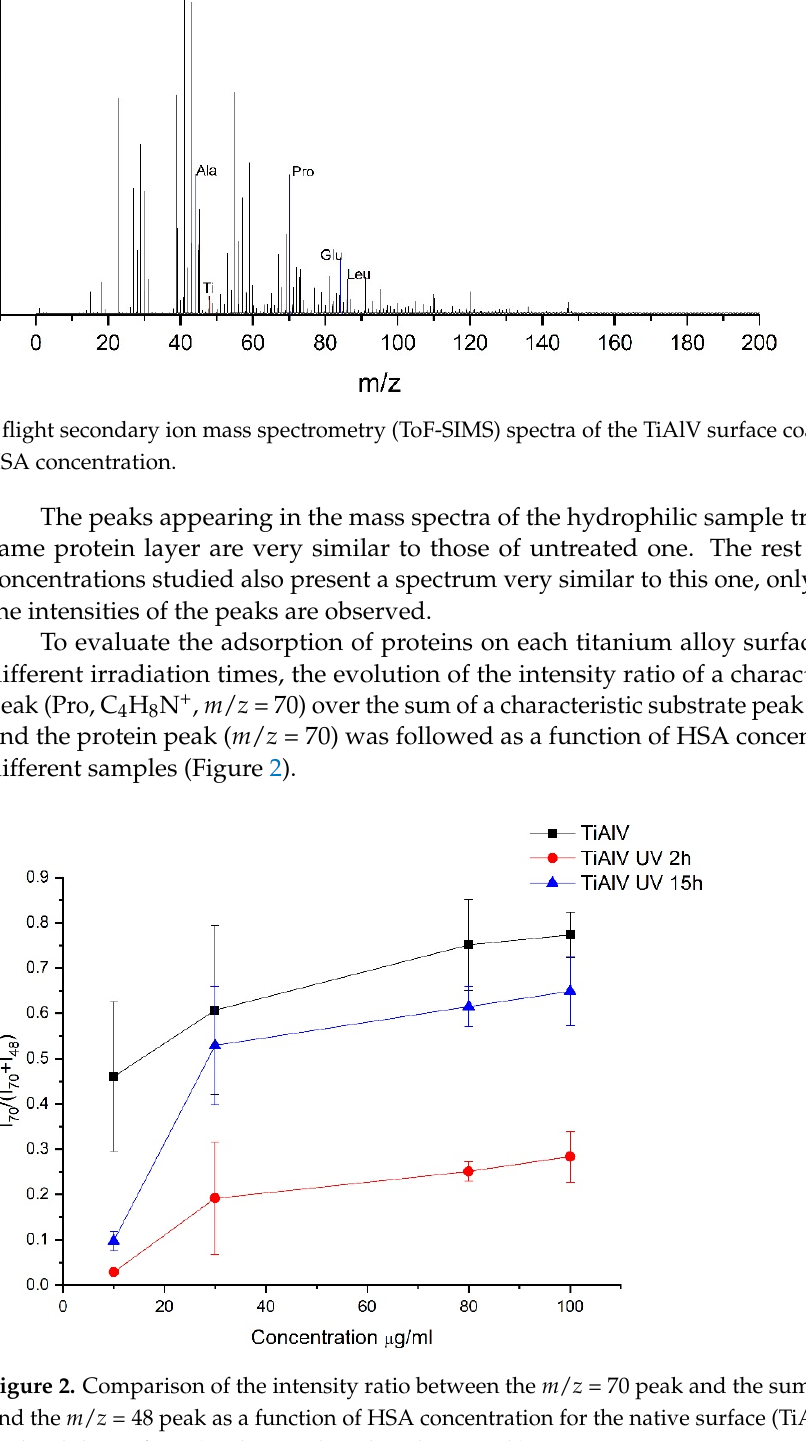
Figure 2. Comparison of the intensity ratio between the m / z = 70 peak and the sum of the m / z = 70 and the m / z = 48 peak as a function of HSA concentration for the native surface (TiAlV) and the